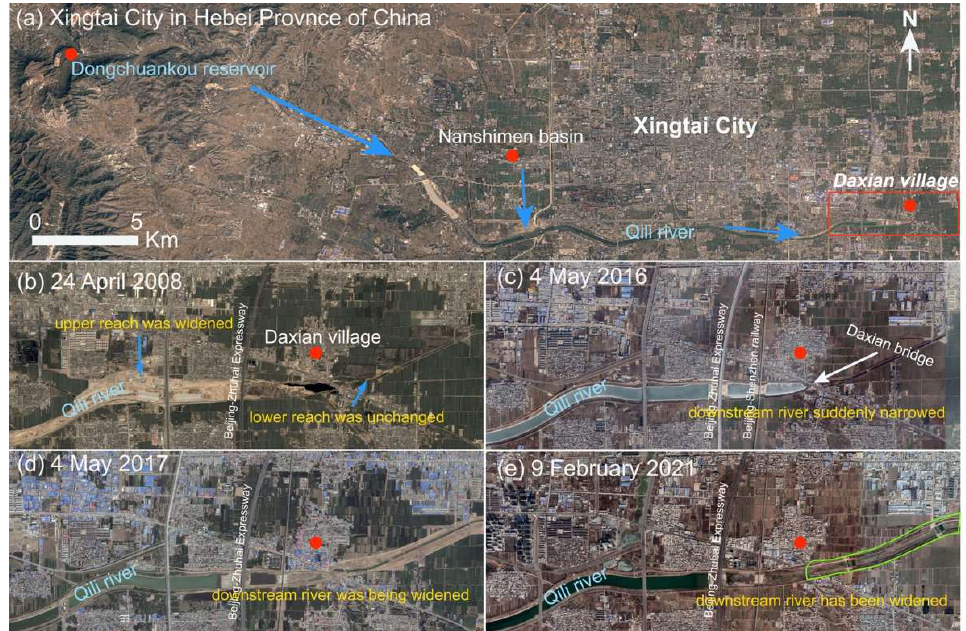
Figure 4. The position ( a ) of Daxian village in Xingtai City, Hebei Province and its time-series satellite images in 2008 ( b ), 2016 ( c ), 2017 ( d ), and 2021 ( e ). The lower reach of the Qili River was widened in 2017 after the 2016 flood disaster.